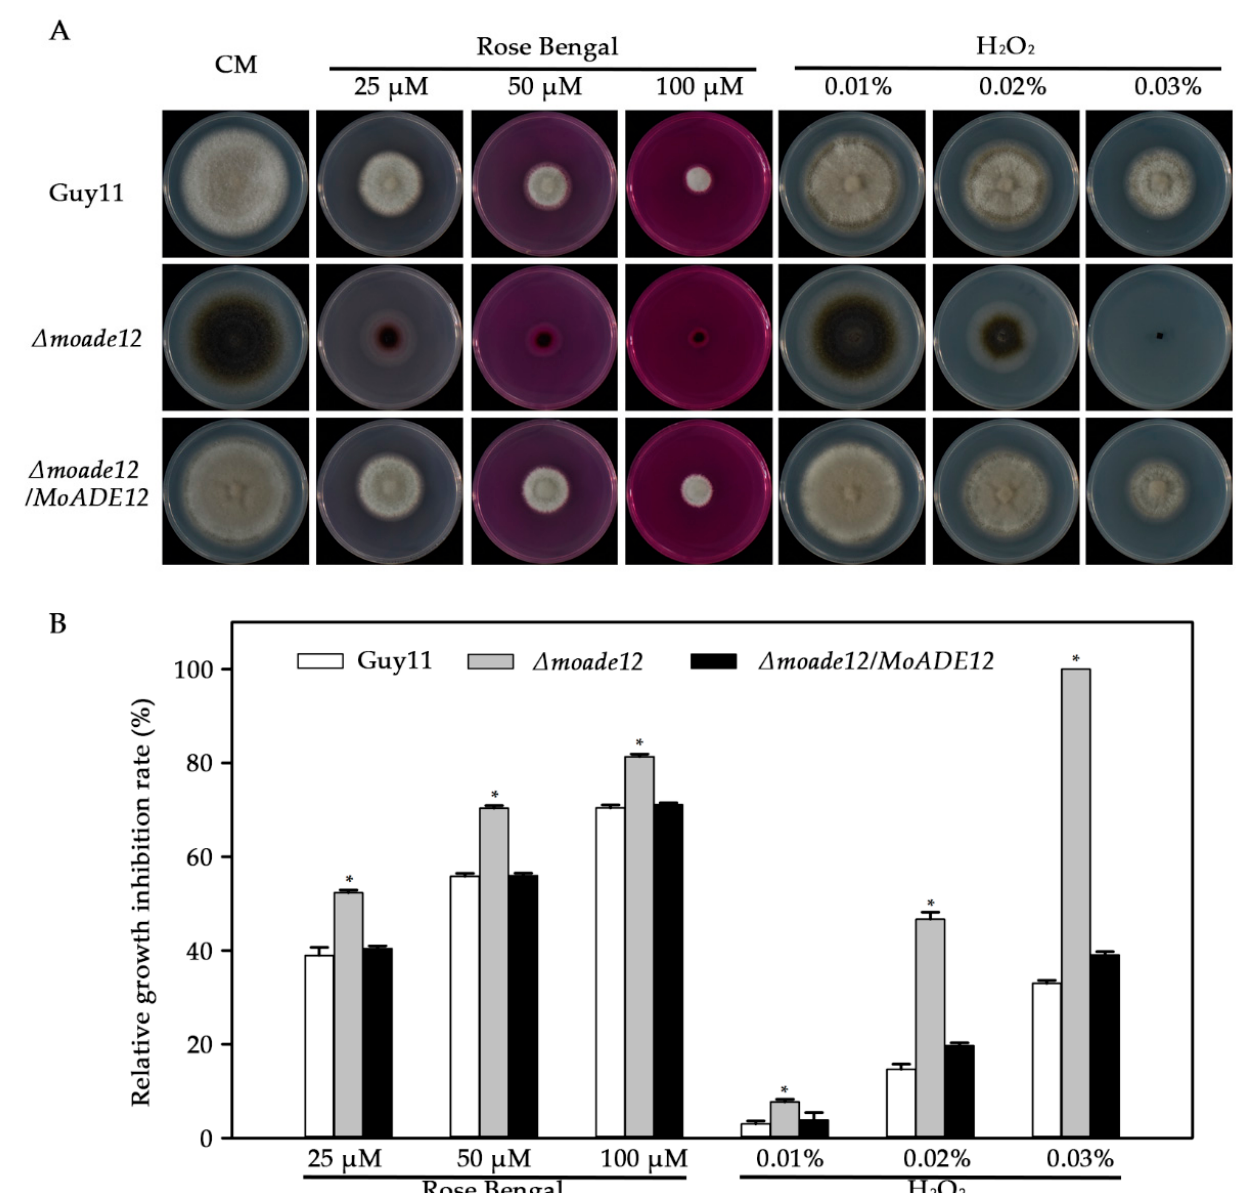
Figure 5. Effects of different oxidants on vegetative growth of the indicated M. oryzae strains. ( A ) Vegetative growth of Guy11, Δ moade12 , and Δ moade12/MoADE12 on CM containing rose Bengal (25 µM, 50 µM, and 100 µM) and H 2 O 2 (0.01%, 0.02%, and 0.03% [ w / v ]) at 28 °C for six days. ( B ) Growth inhibition rates of the indicated strains administered different oxidants. The experiments were performed in triplicate. ANOVA was performed after arcsine transformation of the growth inhibition rates. However, the original percentages are shown in the figure. Error bars represent the SD. Asterisks in each data column indicate significant differences at p < 0.05.